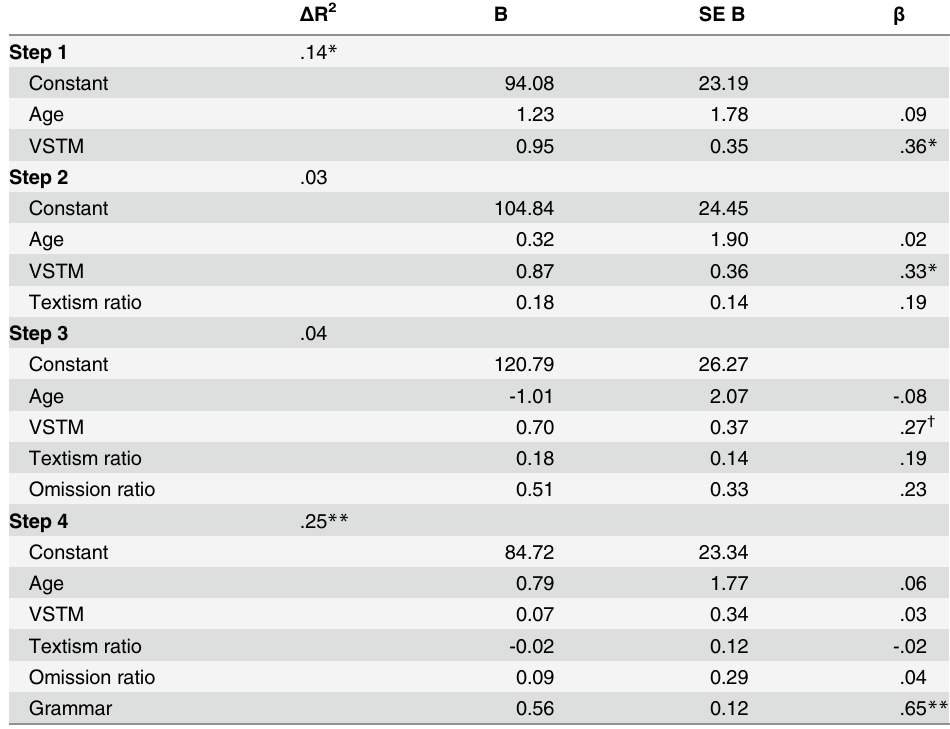
Table 8. Hierarchical regression analysis with children ’ s receptive vocabulary scores as dependent